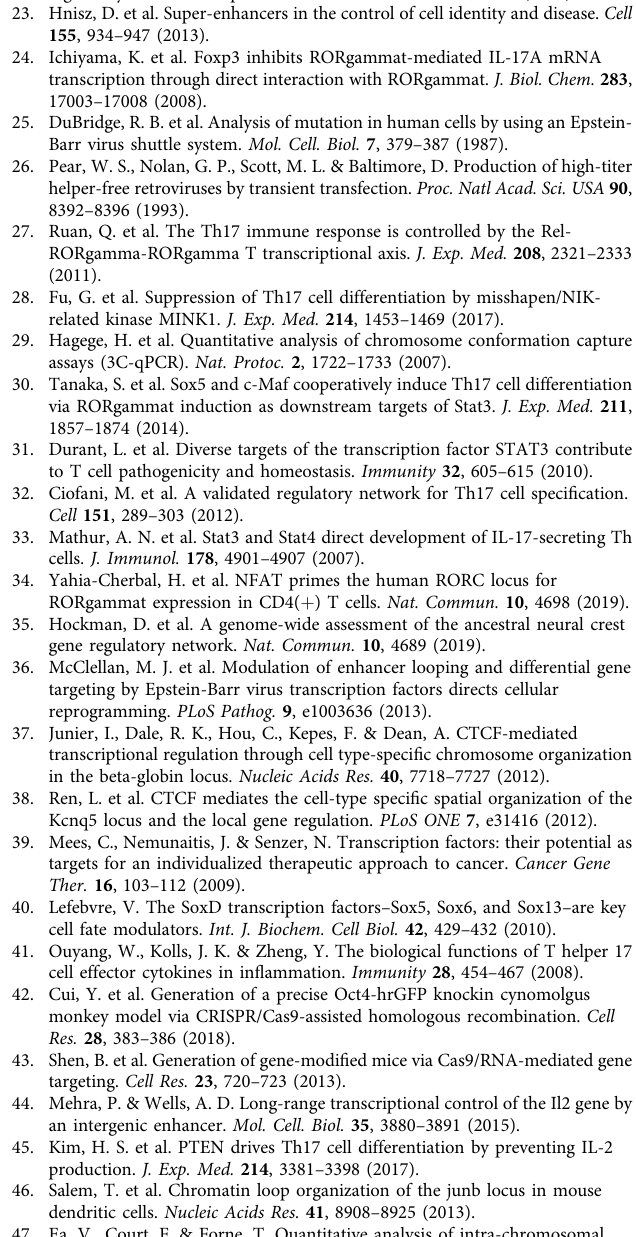
Fig. 10 STAT3 is necessary for the activation of RORCE2. a Red vertical line shows STAT3 binding site (STAT3-BS) in RORCE2, which is located approximately 50 bp downstream of the SOX-5-BS. b , c A ChIP-qPCR assay was performed to determine the enrichment of STAT3 in its binding site in RORCE2 in EL4 cells ( b ), WT Th17-polarized cells before and after STAT3 overexpression or knockdown (KD) and Th17-polarized cells generated from SOX-5-BS-de fi cient mice ( c ). Th17 D represents Th17-polarized cells, and N represents naïve cells. d Relative expression of Stat3 , ROR γ t , and IL-17A genes in WT Th17-polarized cells and IL-17A production in culture supernatants before and after Stat3 overexpression or knockdown (Stat3 KD) were determined by RT-qPCR and ELISA, respectively. e Luciferase assays were performed with different reporter constructs in EL4 cells. RORCE2 with a STAT3-BS deletion (E2- Δ Stat3BS) was cloned upstream of ROR γ t promoter in the pGL3 vector, and transcriptional activity was assessed with a dual-luciferase system. f Hela cells were transfected with pcDNA3.1-SOX-5 Flag vector together with pcDNA3.1-STAT3 HA vector and then cultured for 48 h. After stimulated with PI and Biochanin A, whole-cell lysates from Hela cells were subjected to IP with anti-HA antibody or control mouse IgG, and IB with anti-HA or anti-Flag HRP antibody. Input proteins (input) were also IB with anti-HA or anti-Flag HRP antibody. g Whole-cell lysates from Th17 cells were subjected to IP with anti- STAT3 antibody or control mouse IgG and IB with anti-SOX-5 or anti-STAT3 antibody. Input proteins (input) were also IB with anti-SOX-5 or anti-STAT3 antibody. Mean ± SEM are shown, n = 5 independent experiments, unpaired two-tailed Student ’ s t -test ( b – e ). Experimental mice were between 8 and 12 weeks of age, with no preference to gender and were maintained on a C57BL/6 background. Source data are provided as a Source Data